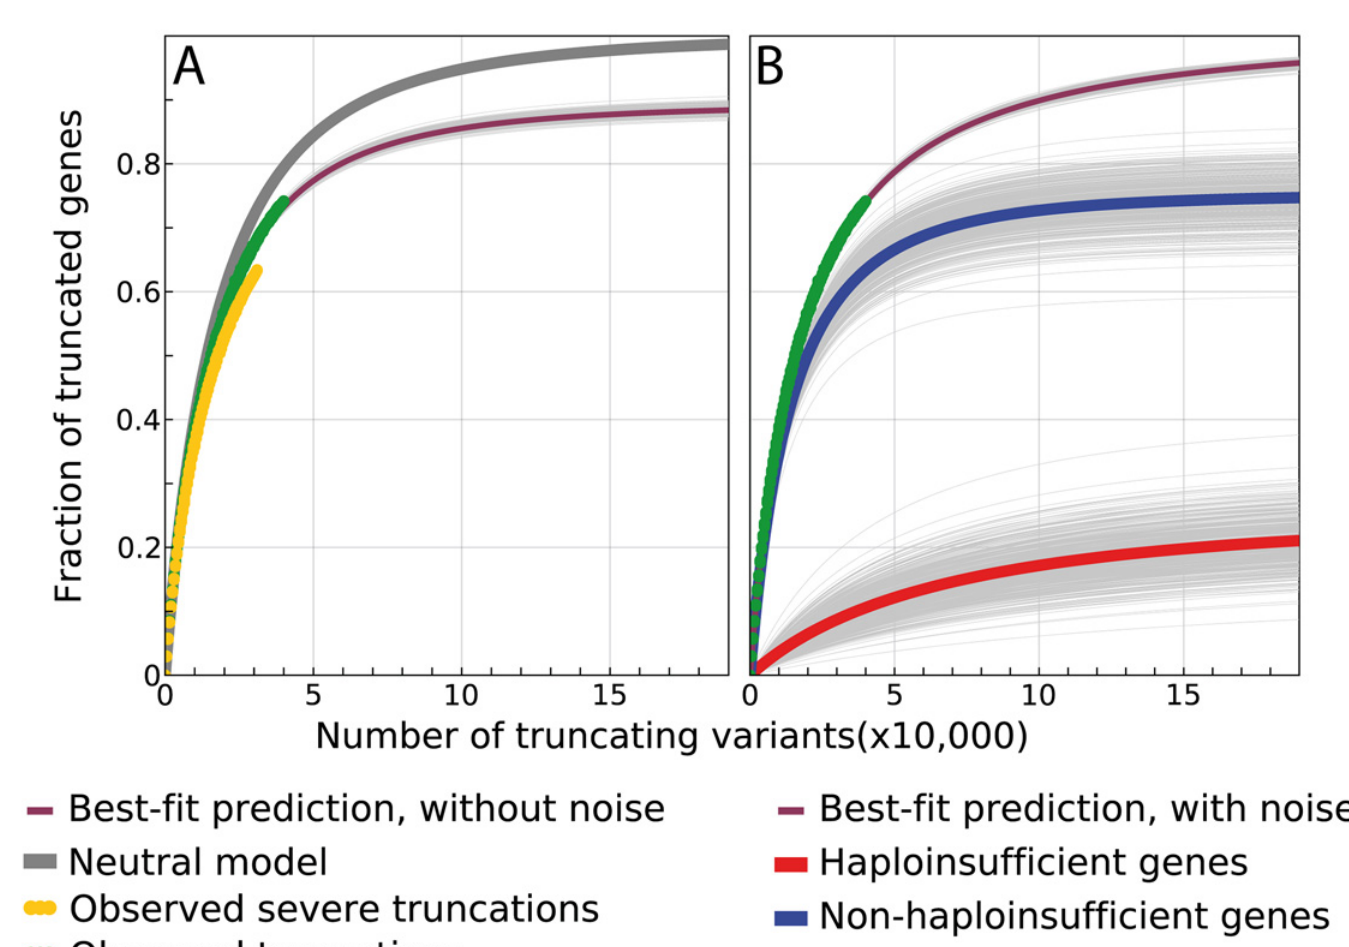
Fig 1. Observed and expected PTVs in the study population. A : Fraction of genes with at least one stop-gain or frameshift variant as a function of the number of sampled PTVs. The gray curve shows the expected number of genes under a model of neutral de novo mutation rate [12] representing the null hypothesis (no deleterious effects). The green curve shows the number of genes observed with at least one PTV. The orange curve limits the number of observed genes to those hosting highly damaging variants [13]. The purple curve shows the predicted number of genes with at least one PTV under the estimated best-fit parameters under model A – bootstrap replicas of this fit is shown by pale gray (see Methods). B : Extrapolation of the observed number of genes with at least one PTV assuming a model that includes the possibility of finding PTVs due to biological and technical noise. The purple curve shows the predicted number of genes with at least one PTV under the estimated best-fit parameters, while the green curve shows the observed data. Decomposition of the observed and predicted number of genes with at least one PTV: variants in non-haploinsufficient genes (blue) saturate early; variants found in haploinsufficient genes (red) continue to accumulate PTVs due to the constant contribution of biological and technical noise.